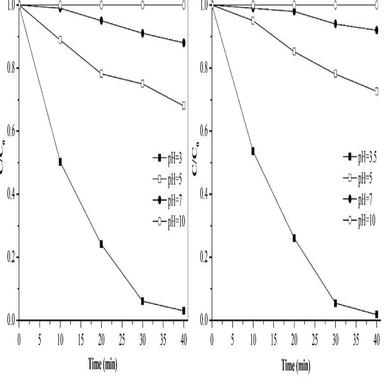
Effect of pH on the degradation of MO and MB. Conditions: dye, 10 mg L1 ; H2O2, 8 mM and Catalyst, 0.06 gL1 .